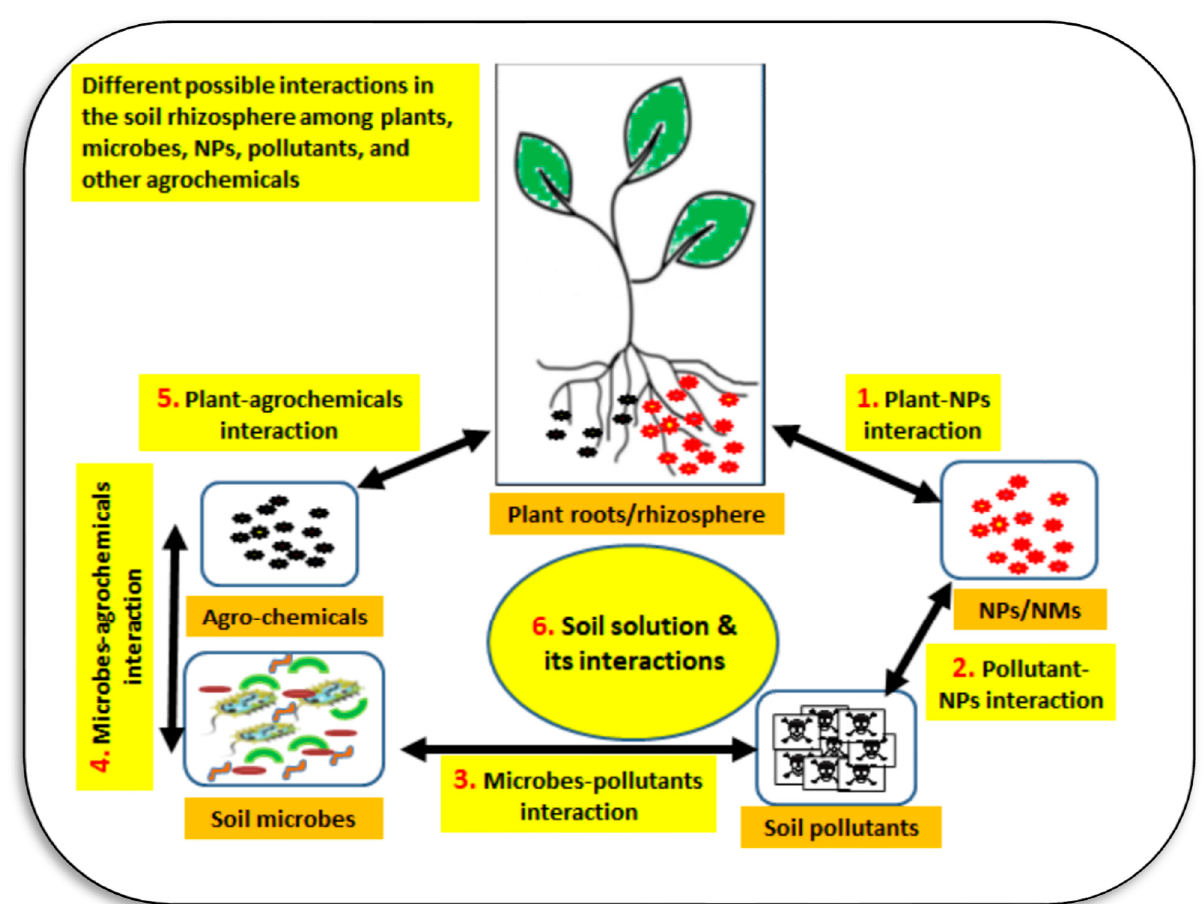
Figure 14. The soil solution is the medium where several interactions among soil microbes, plants, pollutants, agrochemicals, and nanoparticles occur in agroecosystems. These interactions can hap- pen in the soil, with many positive and negative impacts on soil health and fertility. Sources: